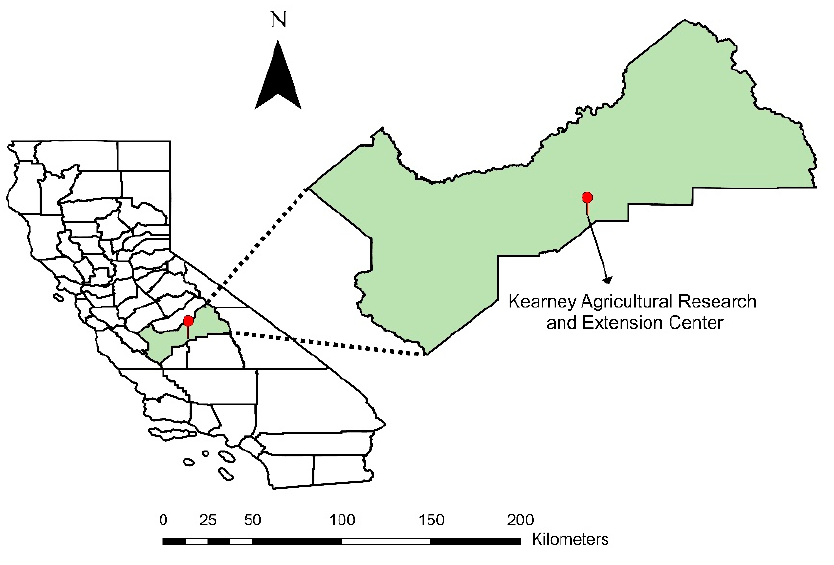
Figure 1. The location of the study